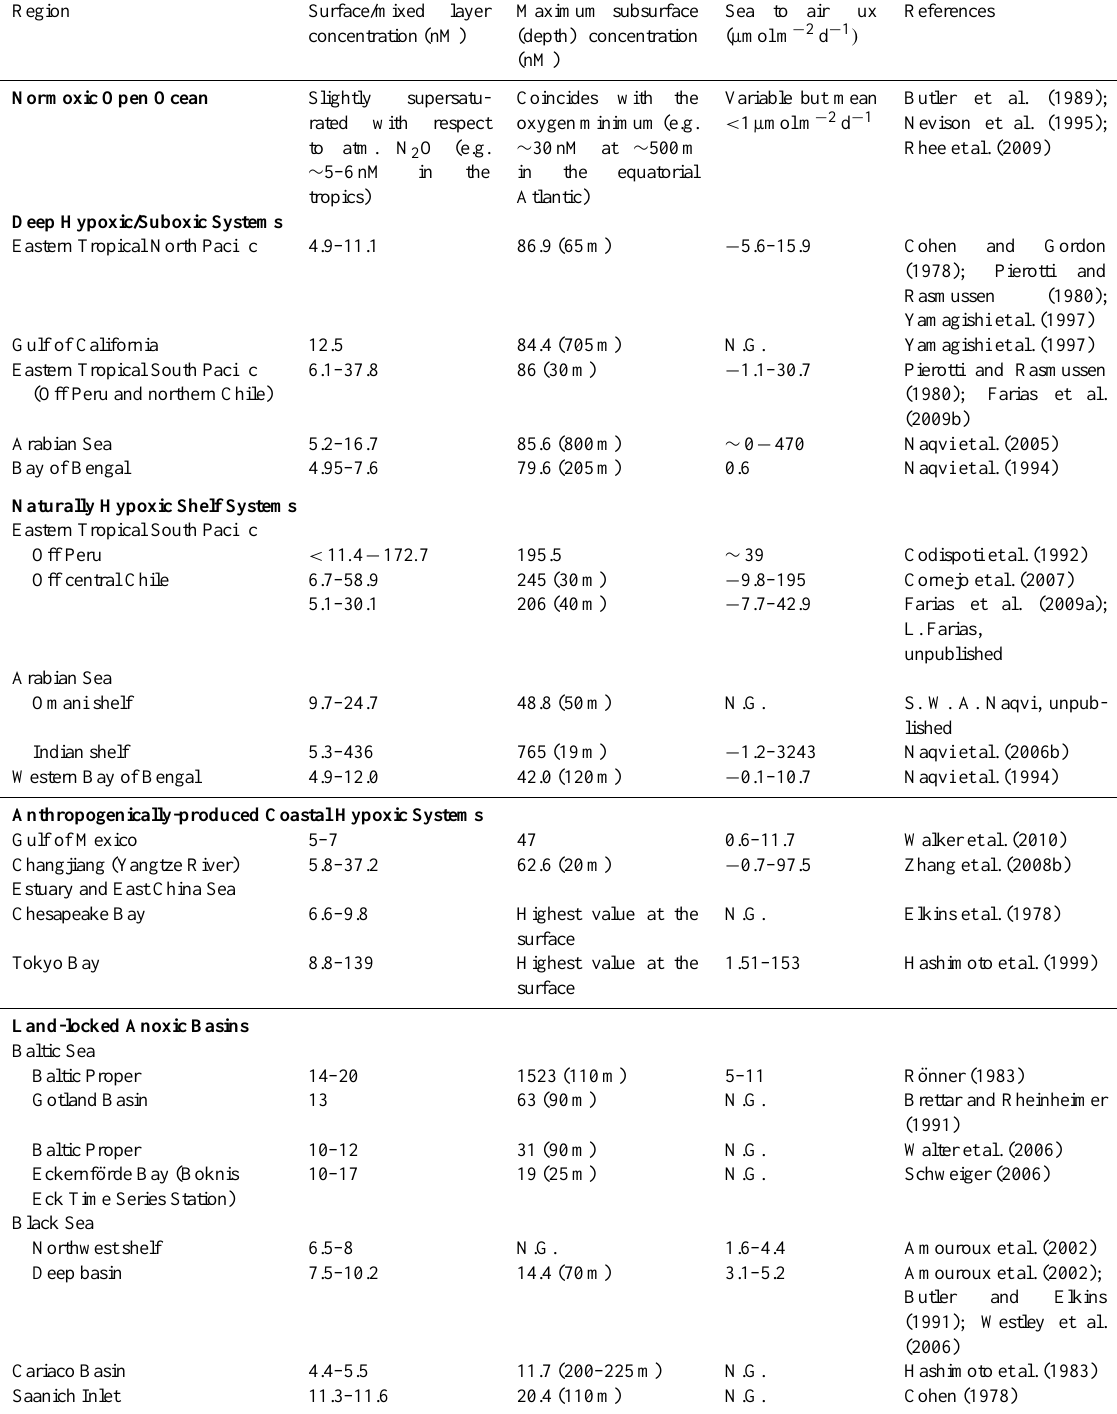
Table 2b. Concentrations and sea-to-air fluxes of N 2 O from major hypoxic/suboxic/anoxic zones.